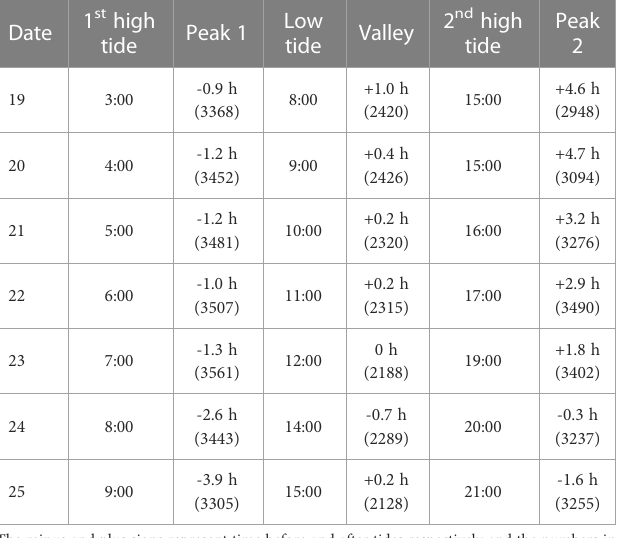
TABLE 2 The time of high and low tides during the 7-day recording period (D19-D25) at side 2, where the times of the snap rate peaks were tracked using the difference between times of the snap peak and high/low tides.